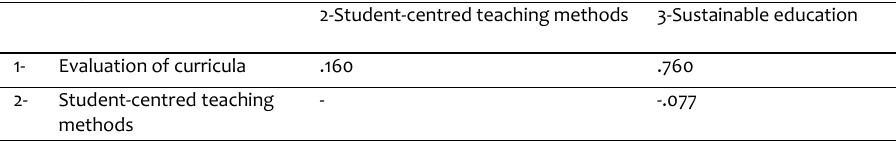
Table 2: Degrees of relations between the variables 2-Student-centred teaching